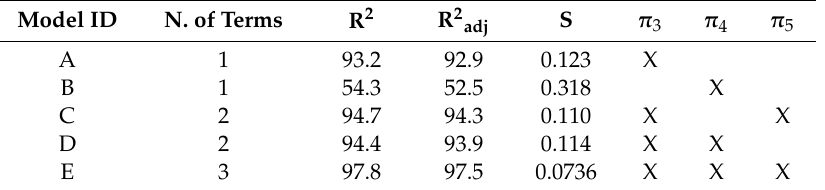
Table 7. Best subsets regression for 2 DC.